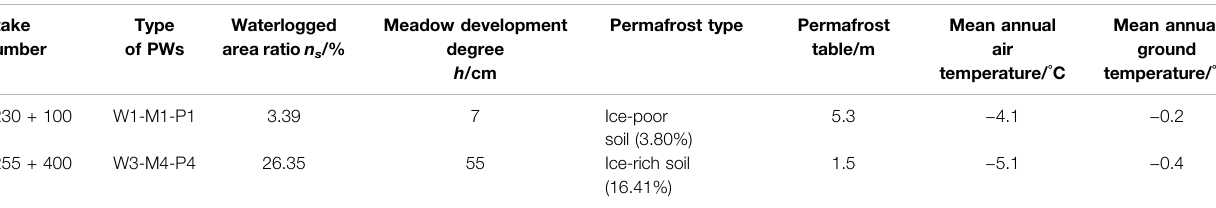
TABLE 7 | PWs type and permafrost property.